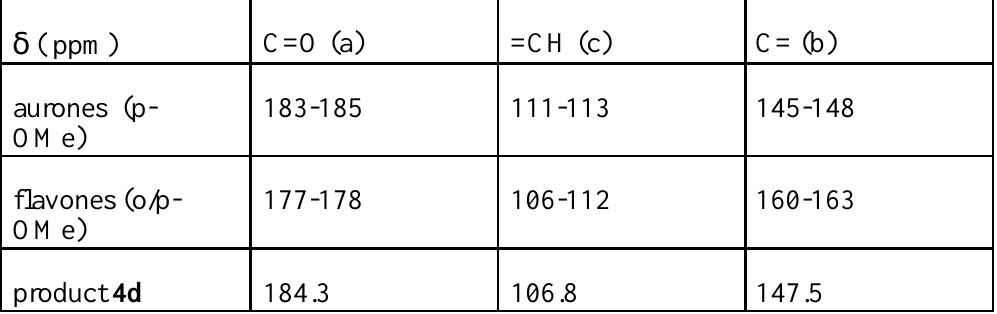
Table 2. Comparison of chemical shifts of 4d and literature